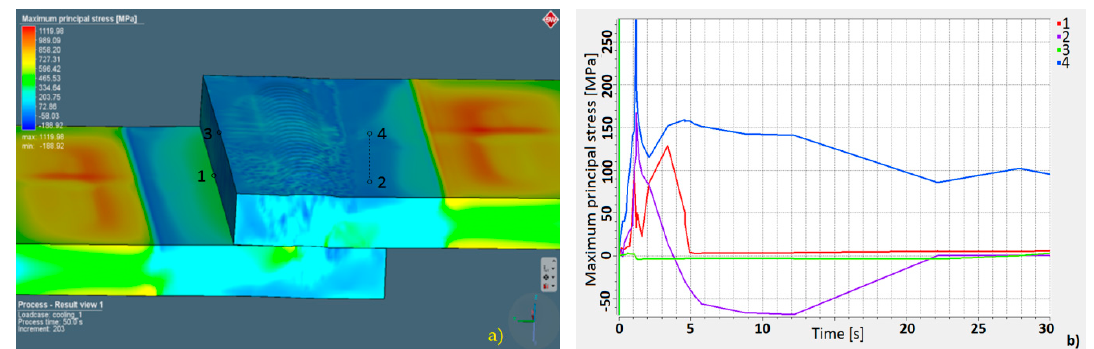
Figure 10. Maximum principal stress: ( a ) distribution map and ( b ) stress chart according to measurement points.